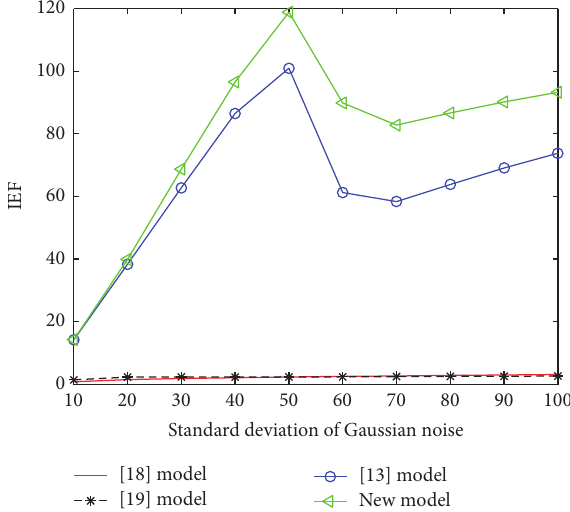
Figure 9: PSNR (dB) graph of [13, 18, 19] and new algorithms for various Gaussian noise for Tennis video sequence.